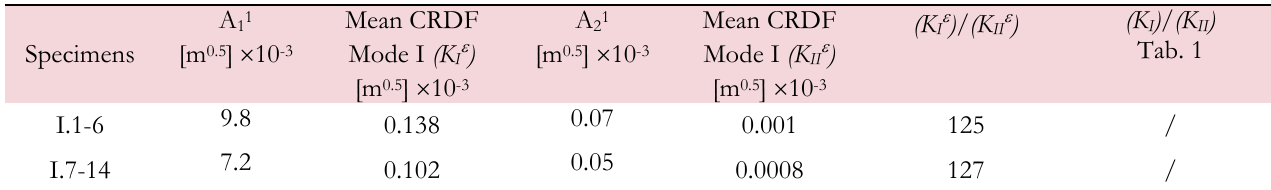
Table 3: Single Edge Notch Bend Test– Crack Relative Displacement Factor